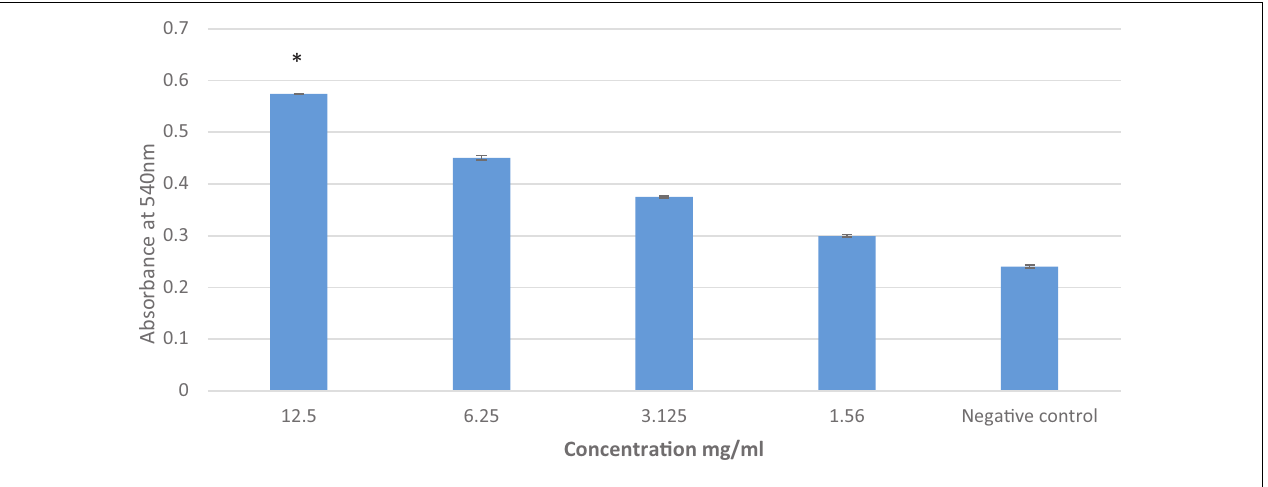
FIGURE 6 | The effect of lemon and ginger combination water extract on macrophage pinocytosis. Results are expressed as means of three independent experiments (bars) ± SEM (lines). ∗ Significant effect of the herbal drink on the pinocytosis activity at the highest concentration when compared with negative control.